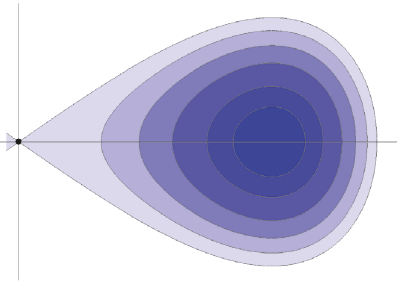
Figure 1: Energy level lines of system (7) in the phase-plane (𝑢,𝑢 󸀠 ) , 𝑢 ≥ 0 , for 𝑉 = 1 , and 𝑝 = 3. A darker color represents a lower value of the energy of the